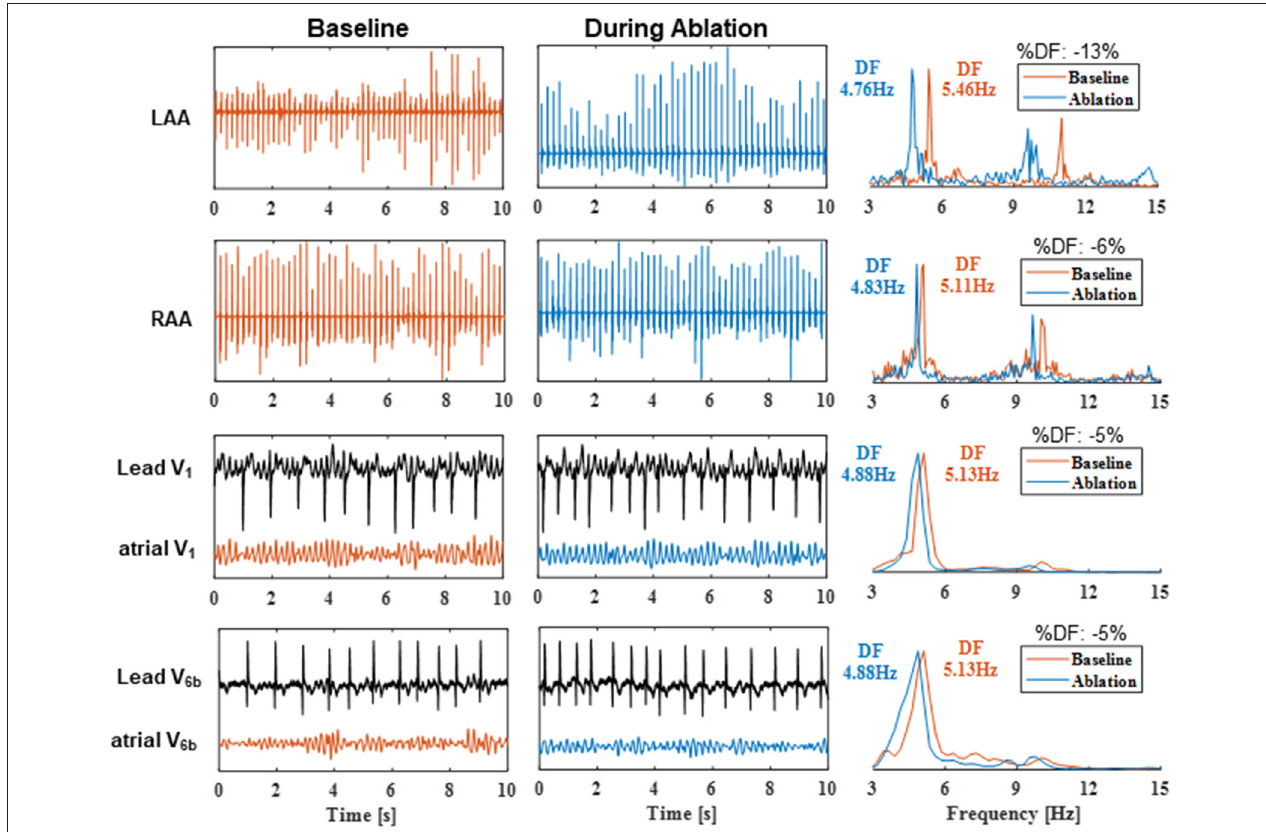
FIGURE 1 | Dominant frequency estimation on 10-s epochs recorded from the LAA, RAA, and the ECG leads V 1 and V 6b in an LT_SR patient at baseline and after 20min of cumulative CFAEs and linear ablation. For the surface ECG recordings, the atrial V 1 and V 6b signals represent the ECG leads V 1 and V 6b devoid of ventricular activity. The corresponding power spectral densities (normalized by their maximum value) and the estimated DFs are illustrated in the right column. DF, dominant frequency; %DF, relative change in DF during ablation compared with baseline DF values. Other abbreviations as in previous